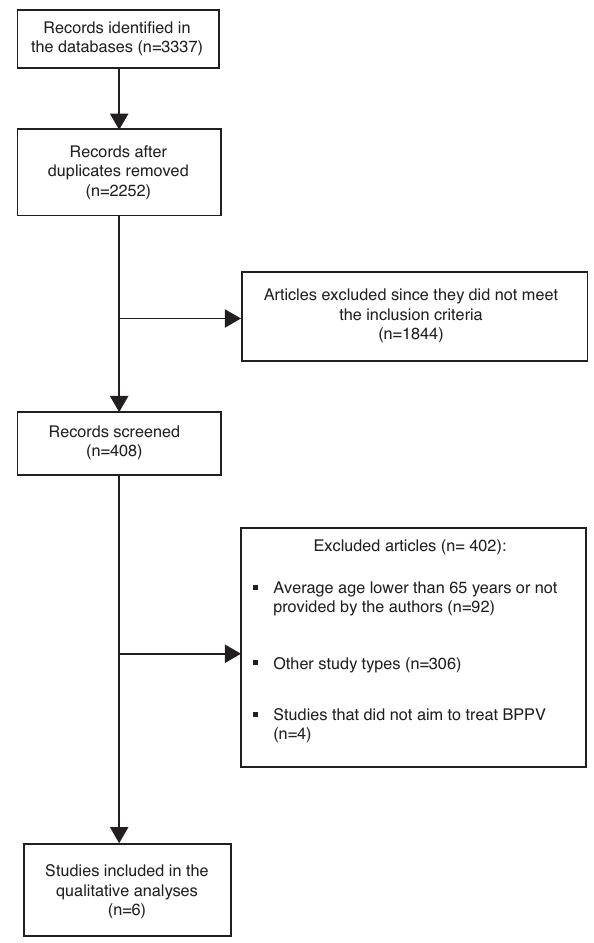
Figure 1 Fluxogram for the selection of articles. pharmacotherapy. 30,34 Table 1 provides details about the intervention strategies used in each